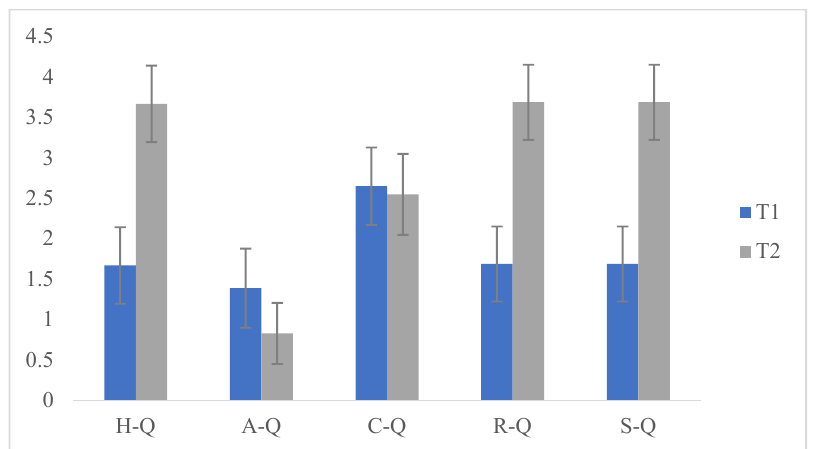
Figure 4. Comparisons Questionnaire, T1 and T2 .